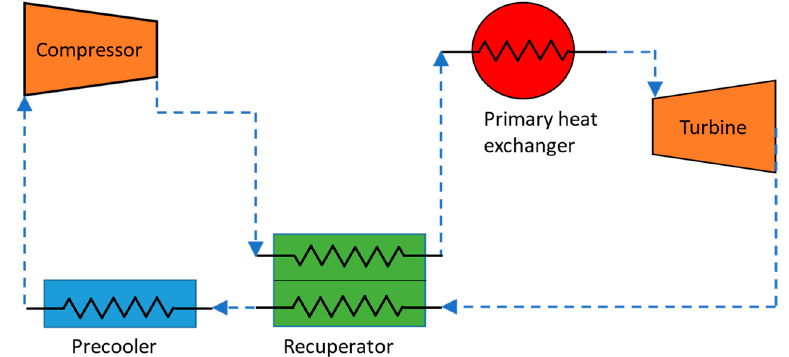
Figure 2. Simple closed-loop Brayton Cycle.